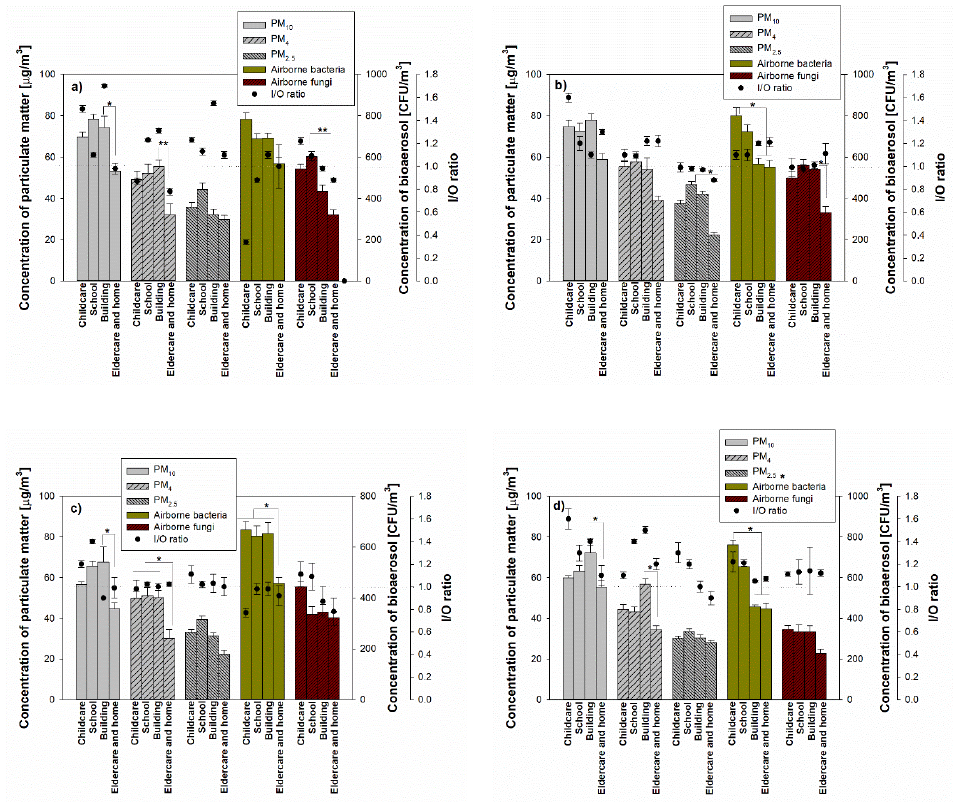
Figure 3. Concentrations of indoor aerosols (particulate matter (PM) 10 , PM 4 , PM 2.5 , airborne